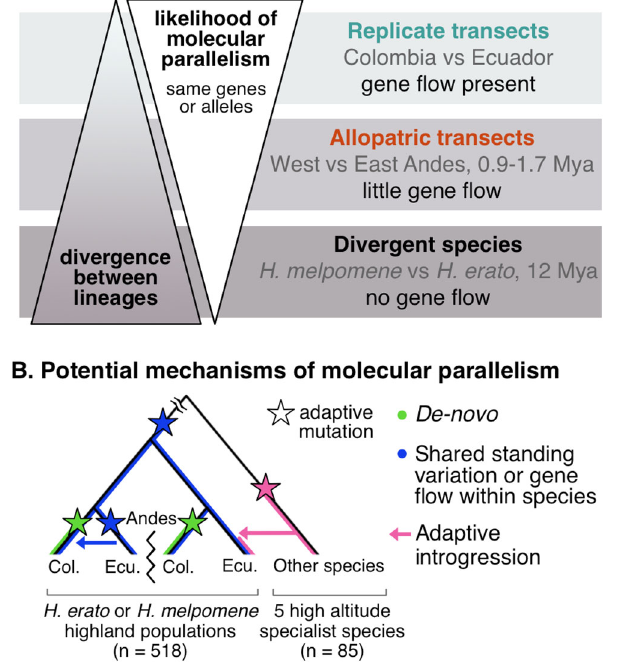
Fig. 1 | The study of repeated adaptation to the environment and the mechanisms potentially facilitating it. A We hypothesise that increasing diver- gence between the lineages under study reduces the likelihood of molecular par- allelism(samegenesoralleles)underlyingrepeatedadaptationtotheenvironment. In this study, we test this hypothesis by sampling replicate (within sides of the Andes) or allopatric (across sides of the Andes) altitudinal transects of the same species, i.e., connected via gene fl ow or not (divergence times indicated in Million yearsago,Mya),andallreplicatedintwodivergent Heliconius species. B Threemain mechanisms can give rise to the genetic variation upon which selection acts repeatedly, giving rise to molecular parallelism: (i) adaptive de-novo mutations independently arise in two or more lineages, (ii) existing shared standing variation is repeatedly selected across lineages or shared via gene fl ow within species, and (iii)adaptiveallelesaresharedviagene fl owacrossspecies(adaptiveintrogression). Wetestedfortherelativeimportanceofthesemechanismswitharangeofanalyses on the relevant transect comparisons. Illustrative tree including four highland populations from four transects (with the Andes preventing gene fl ow between replicate transects across sides) of our focal species, either H. erato or H. melpo- mene ,andalineageofarelatedhigh-altitudespecialistspeciesfromwhichadaptive introgression is plausible. Sample sizes for the full datasets (including lowland populations when present) are shown in